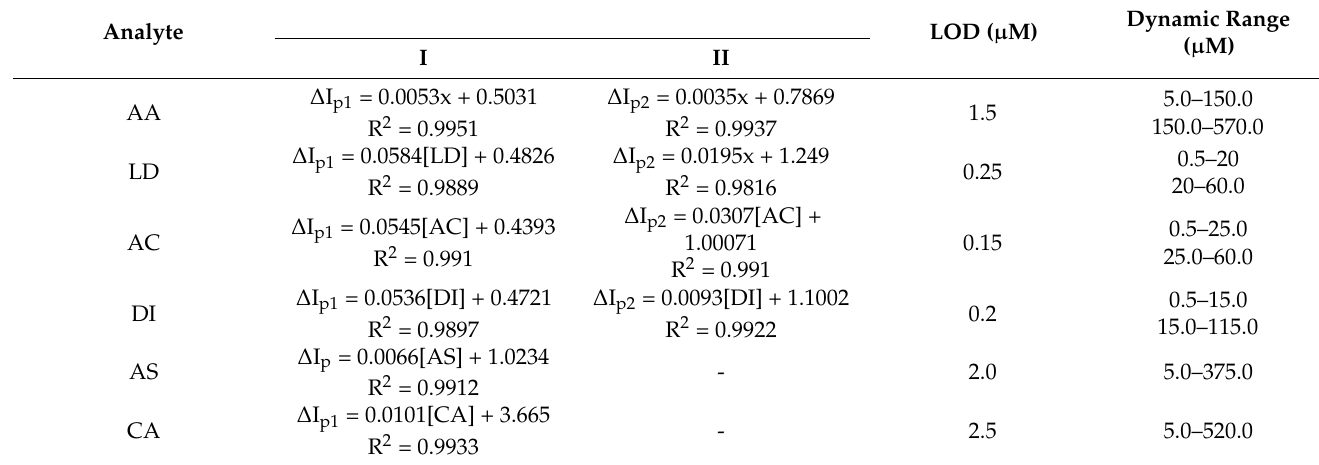
Figure 7. Differential pulse voltammograms for the dependence of oxidation current responses obtained from GCE- tPANI-Au@Pt-MWCNT on the concentration of AA (5.0–570.0 µ M), LD (0.5–60.0 µ M), AC (0.5–55 µ M), DI (0.5–115 µ M), AS (5.0–375.0 µ M) and CA (5.0–520 µ M) in 0.5 M PBS (pH 3.0). Table 1. Summary of the calibration curves and the R 2 values of the linear fit, the limit of detection (LOD) and the dynamic range for the electrochemical detection of six OTC drug molecules using GCE-tPANI-Au@Pt-MWCNT.